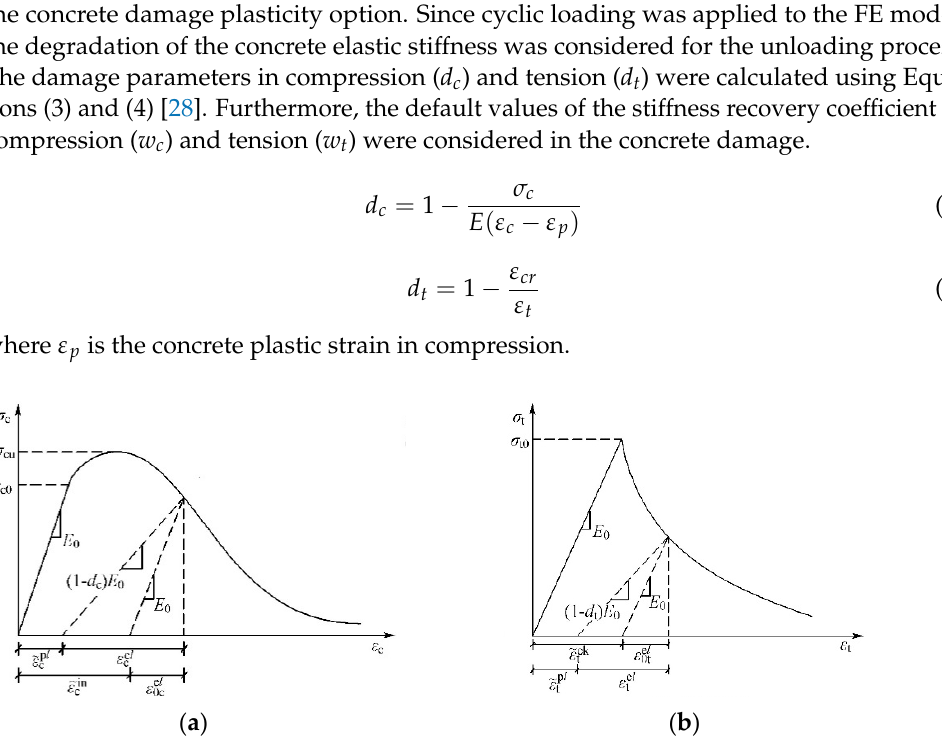
Figure 2. The typical stress–strain relation of the concrete: ( a ) in tension; ( b ) in